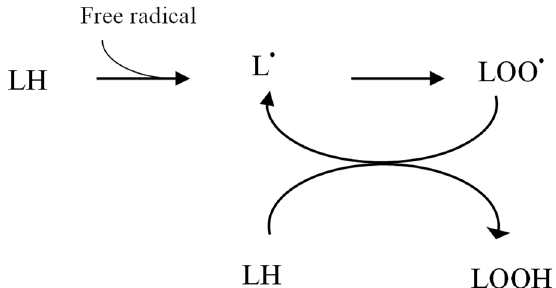
Figure 1. Reactive oxygen species (ROS)-induced lipid peroxidation. LH (lipid), LOOH (peroxide lipid), L • (lipid radical), LOO • (peroxidised lipid radical).